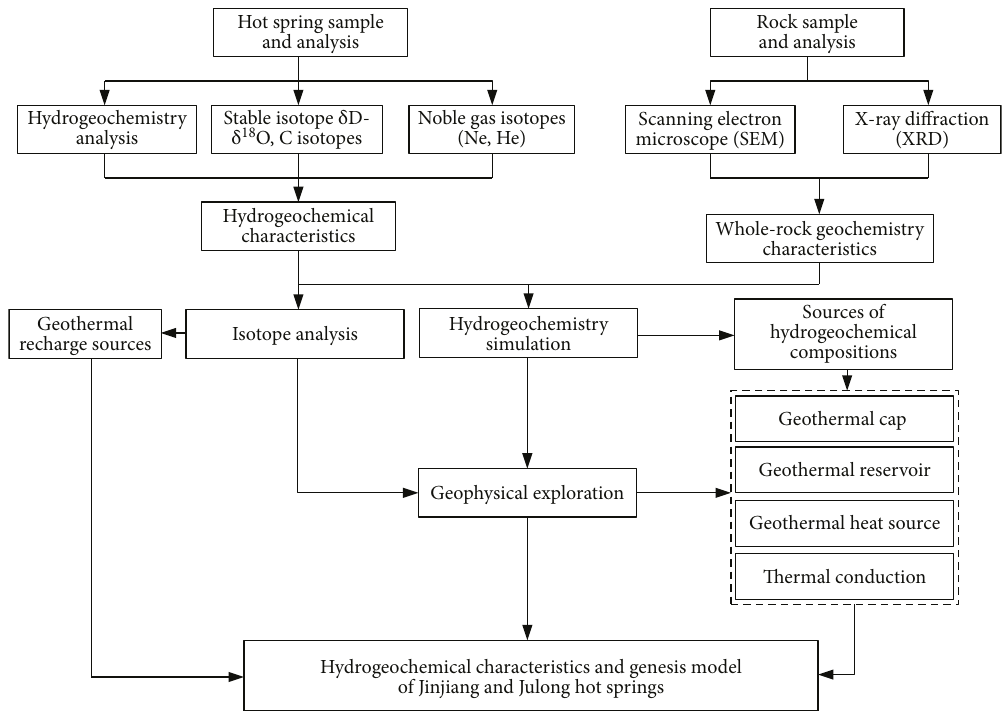
Figure 5: Distribution of MT station at the volcanic area in Changbai